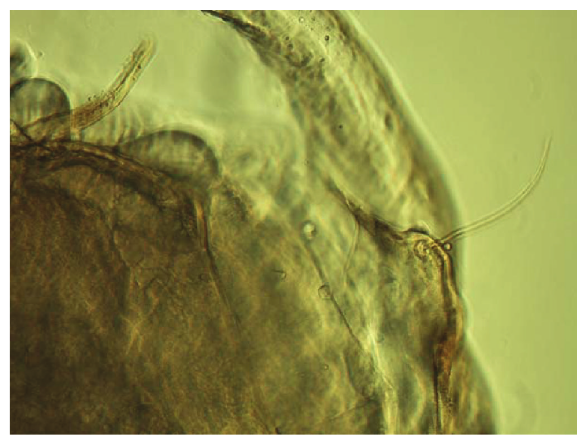
Figure 25: The pleural papillae on the prothorax have the form of flexile socketed setae, that is, sensilla trichodea.